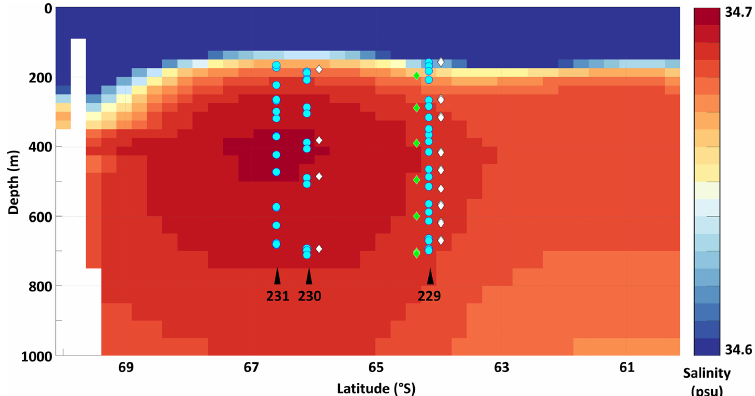
Figure B3. Climatological salinity along the Prime Meridian, from Zweng et al. (2018), showing the comparatively salty CDW in red. For each mooring line (229, 230, and 231), the symbols indicate the depth of the mooring hydrographic sensors during deployments that coincided with polynya events: white diamonds for 1999 and 2000; cyan circles for 2004 and 2005; and green diamonds for 2016. The latitude shift between deployments of the same mooring is for readability only.